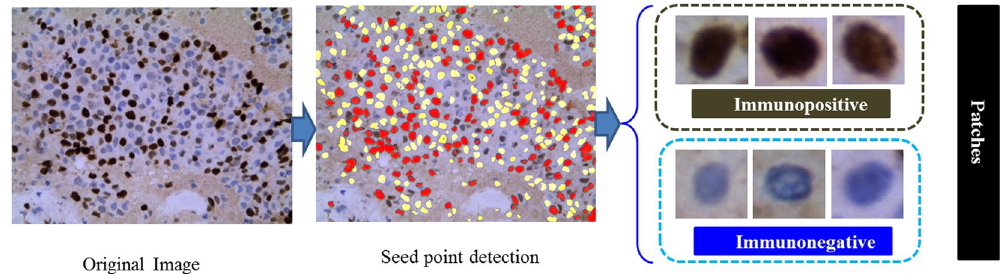
Figure 3. Illustrates the flow diagram of the patch detection from original